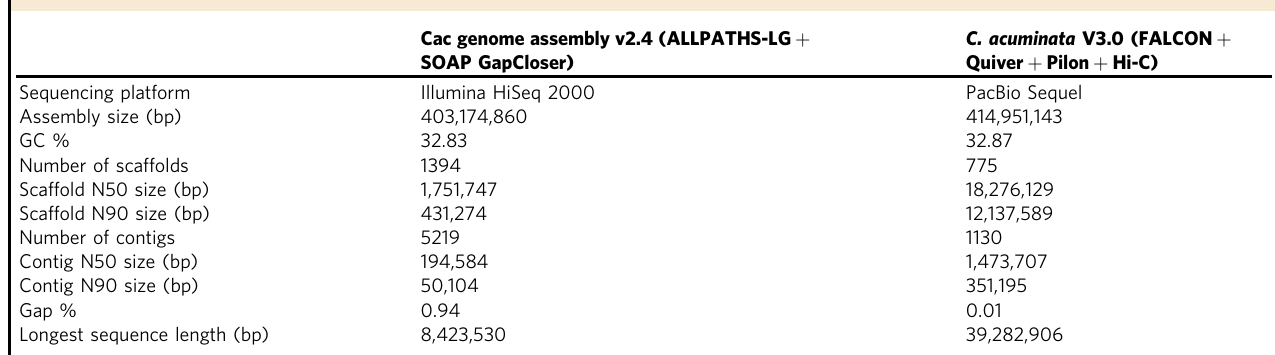
Table 1 Statistics for Cac genome assembly v2.4 and C. acuminata assembly